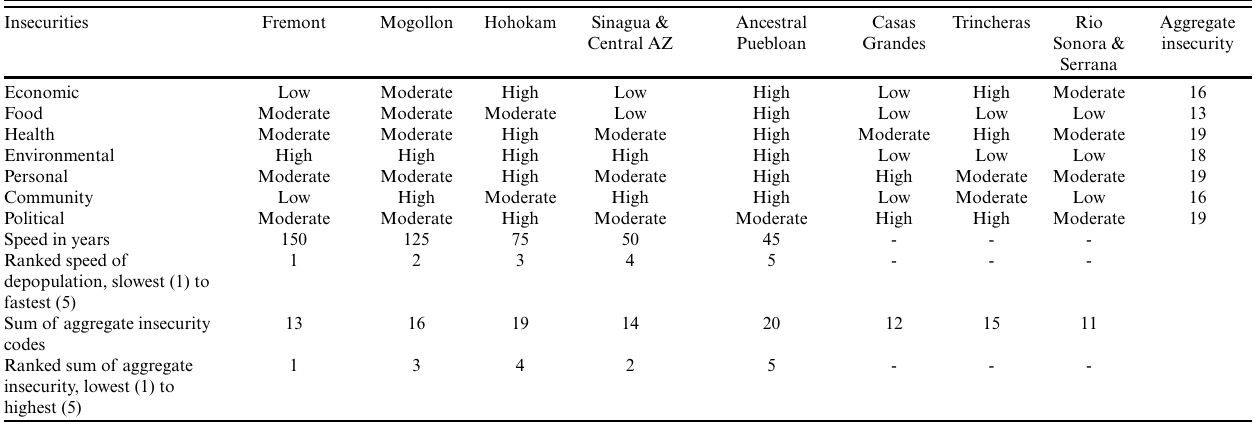
Table 3 . Human insecurities by culture areas, speed of depopulation, and aggregate insecurity.